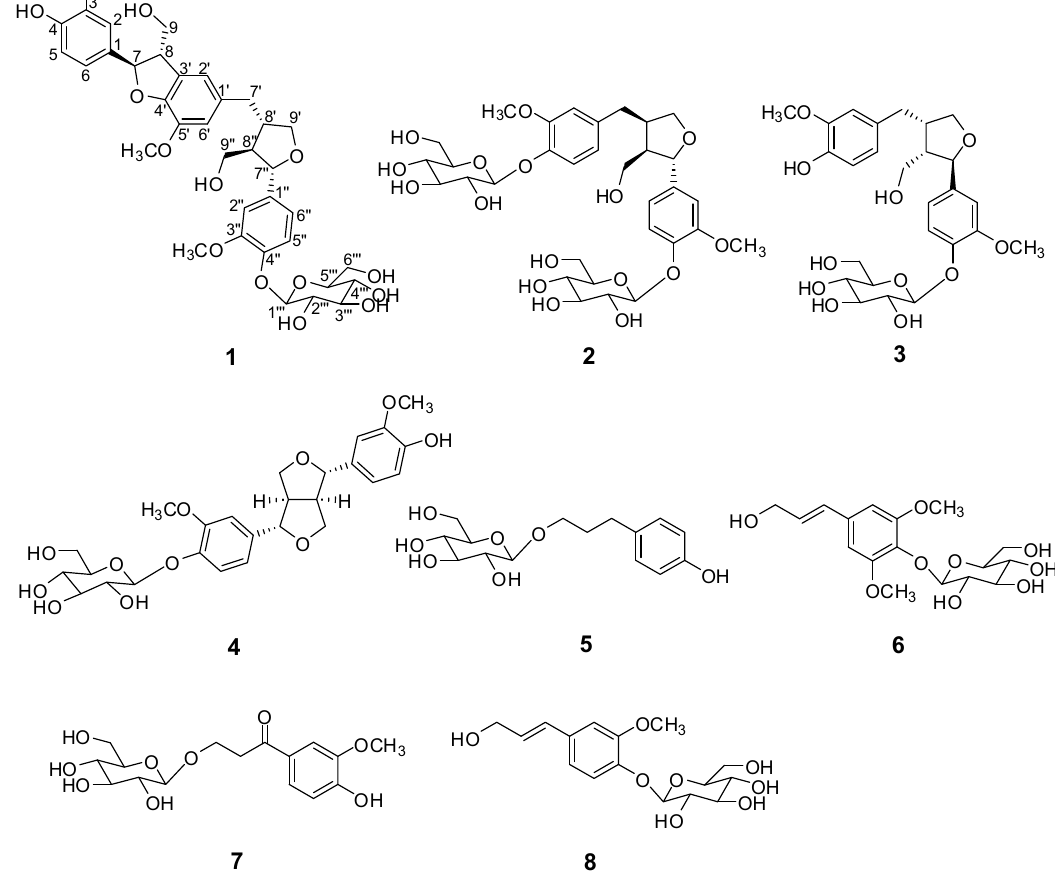
Figure 1. Chemical structures of compounds 1 – 8 .